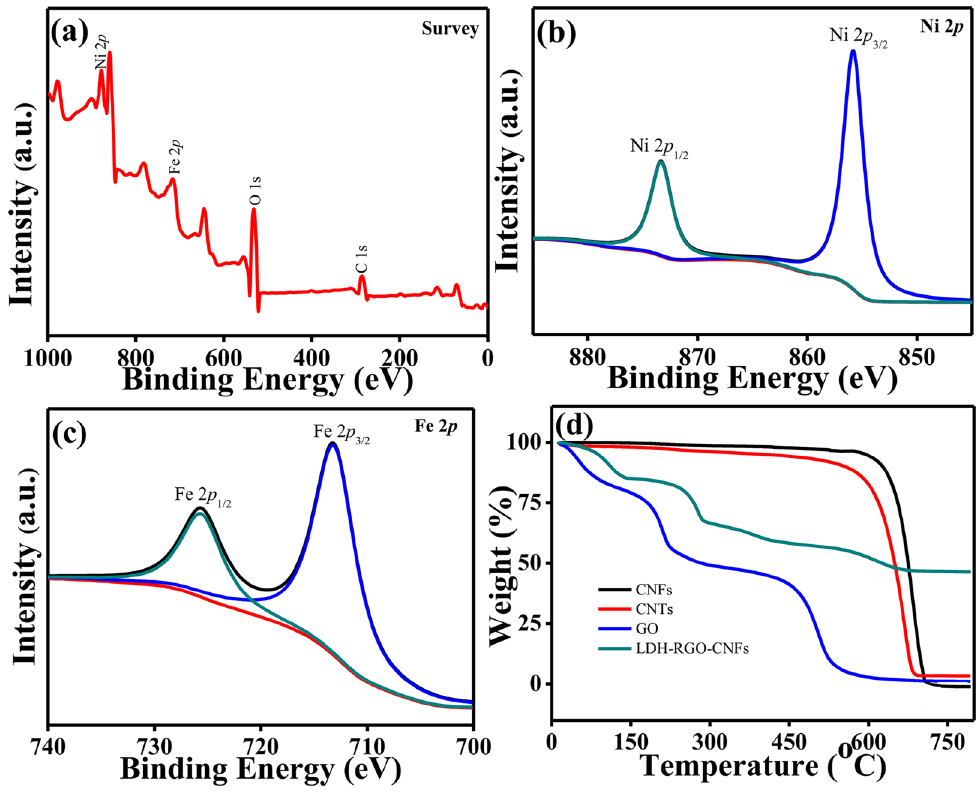
Figure 4. XPS survey and high-resolution spectra of LDH-RGO-CNFs. ( a ) Survey, ( b ) Ni 2 p , ( c ) Fe 2 p ; ( d ) TGA curves of CNFs, CNTs, GO,